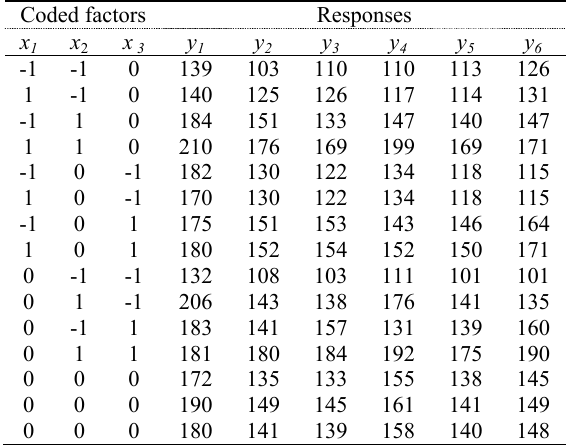
Table 5. Design matrix (BBD) and experimental results Coded